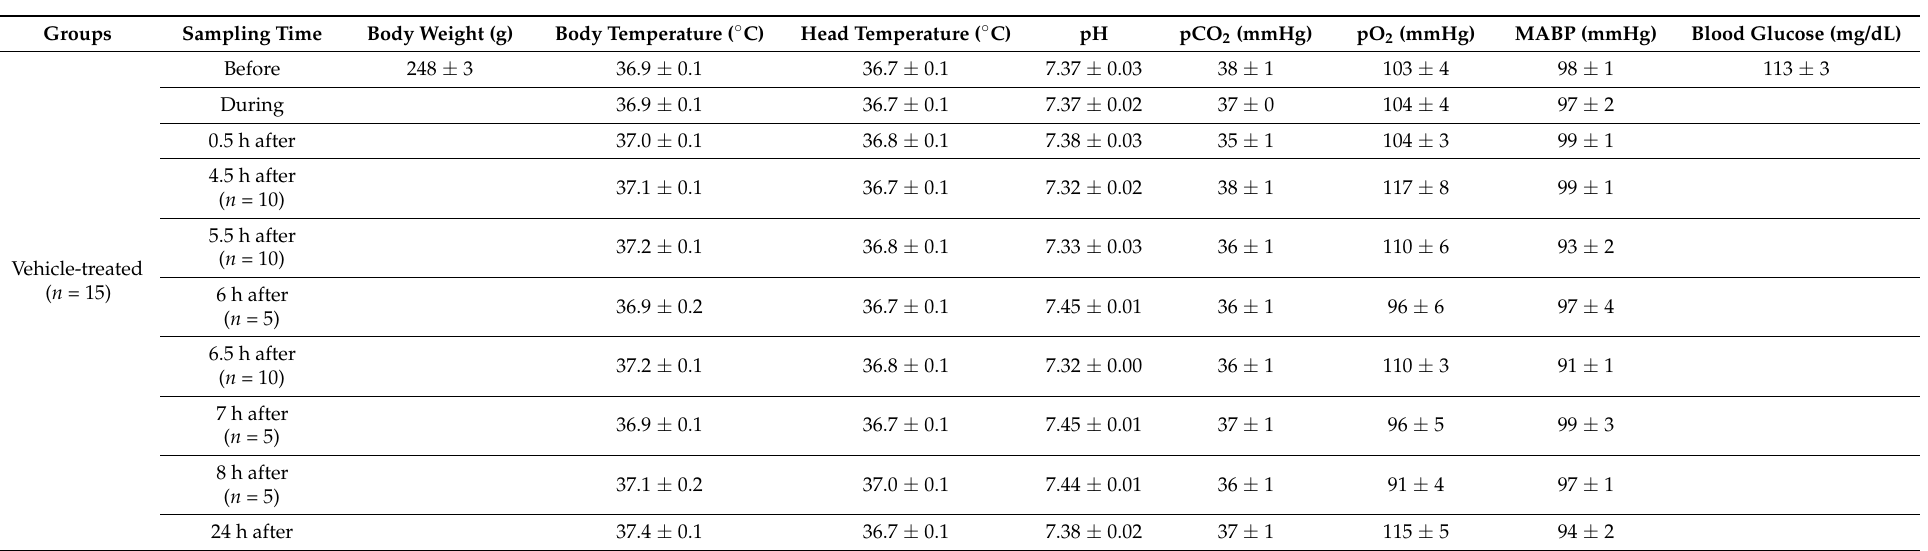
Table 4. Physiological parameters before, during, and after collagenase injection and during vehicle/RMP treatment in female rats employed in the therapeutic window